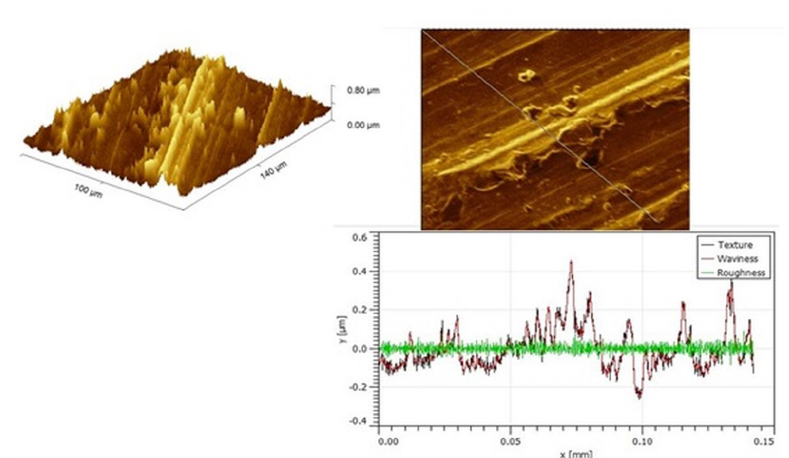
Figure 9. AFM images for the specimen 4 (20N of Load, 400 rpm of disc speed, 6 m/sec of velocity and wear rate of 0.0486 mm 3 /min).